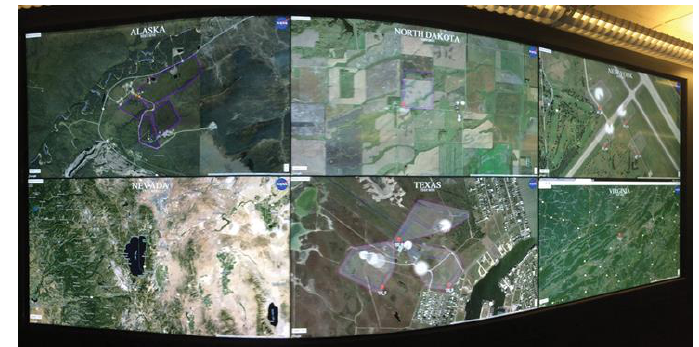
Figure 7. NASA Ames UAS operations for UTM TCL1 [21].